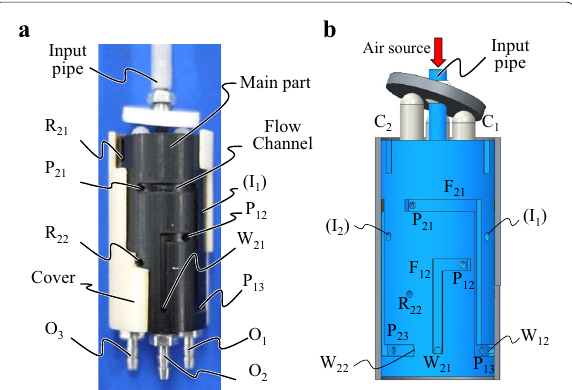
Fig. 7 Actual design of the cylindrical main part and its flow channels. a Photo of the part. b CAD graphic to show the ports